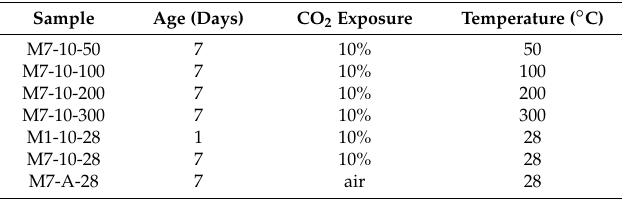
Table 3. Samples analyzed under this